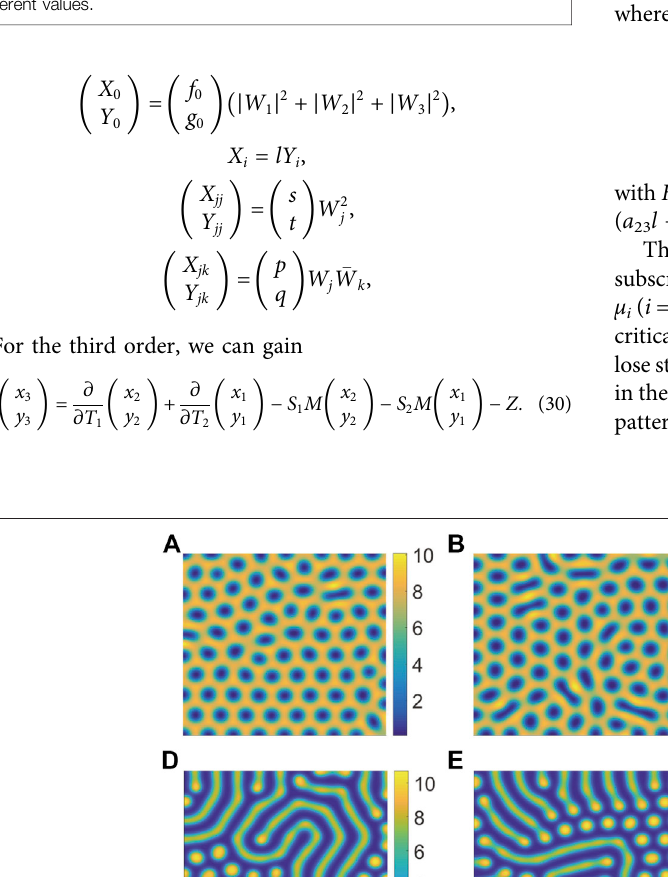
FIGURE 5 | (Color online) The time series of vegetation with P taking different values.